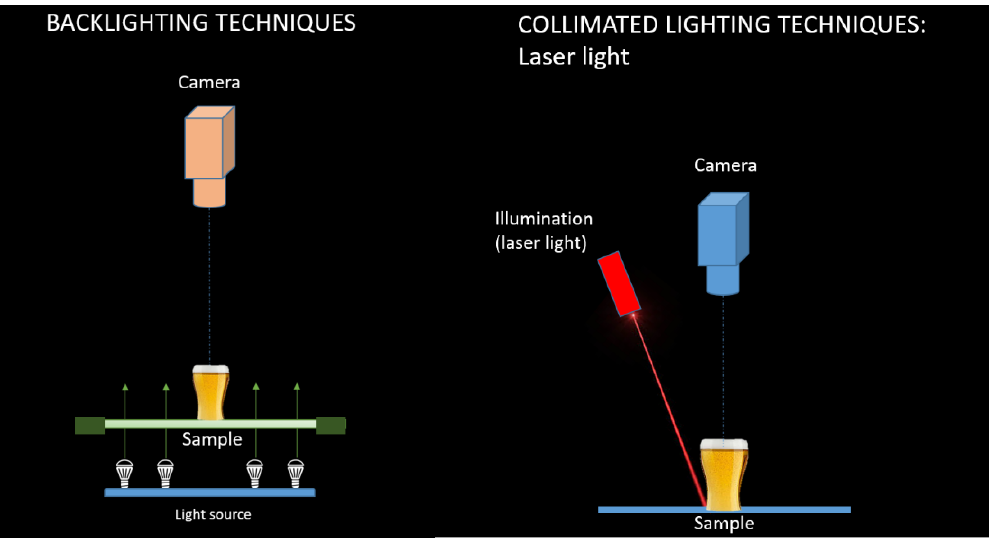
Figure 8. Backlighting and collimated lighting techniques.